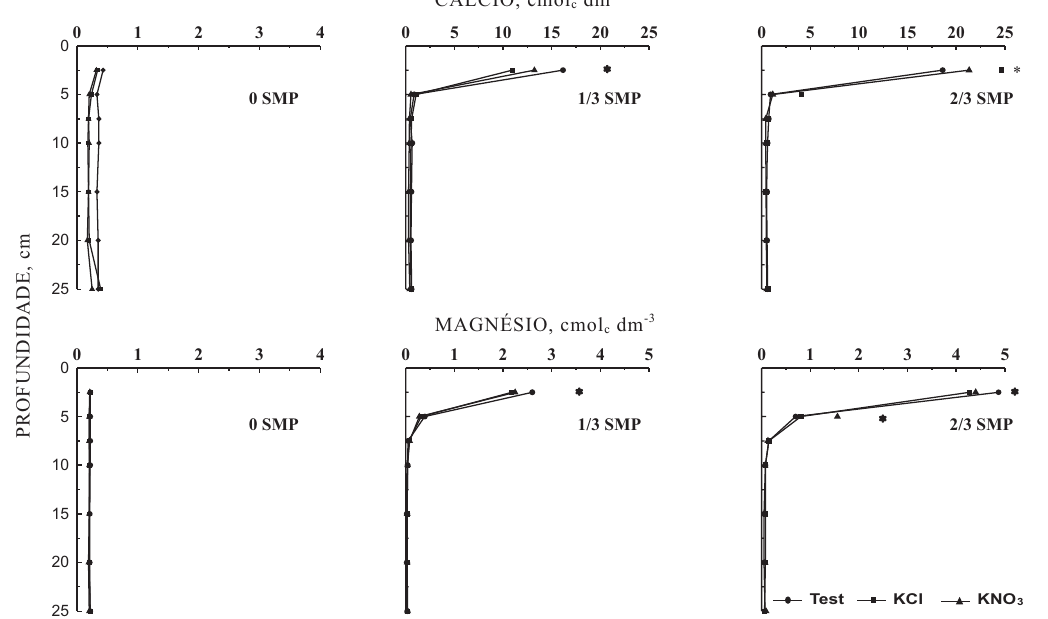
Figura 3. Concentração de cálcio e magnésio trocáveis em colunas de um Cambissolo Húmico, em diferentes profundidades, devido à aplicação superficial de doses de calcário (0, 1/3 e 2/3 da recomendação do método SMP para pH-H O 6,0) combinadas com sais de potássio, após 21 adições de água. Presença de 2 * significa diferença estatística entre a média dos sais potássicos dessa profundidade, em relação à média das demais profundidades, dentro da mesma dose de